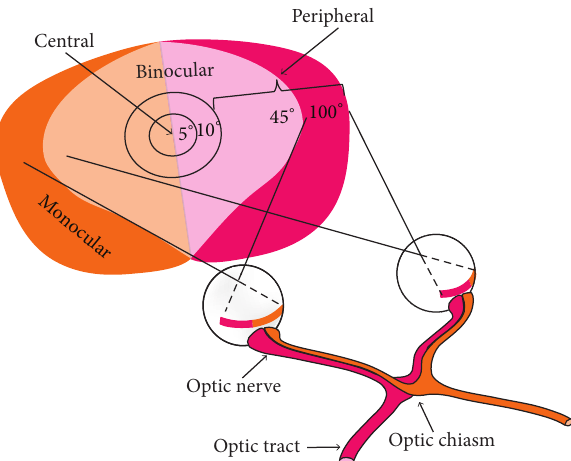
Figure 3: Scheme of the visual field when tested binocularly. Right hemifield is marked in pink and left in orange. Binocular visual field is represented in lighter shade and monocular in darker. Visual input from each half of the visual field after crossing of optic nerves at the optic chiasm is projected via optic tract to the contralateral